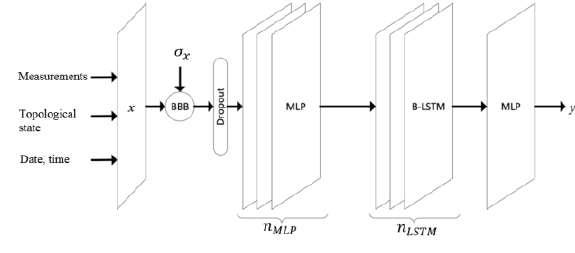
Fig. 7. Architecture of proposed deep ANN